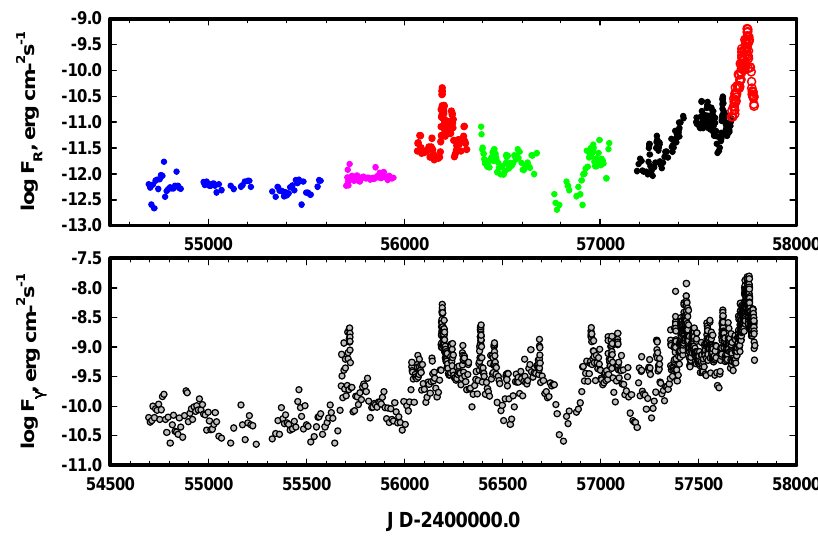
Figure 3. Optical and γ -ray flux evolution from 2008 to 2017 with colour encoded in the upper optical panel corresponding to different stages of activity.